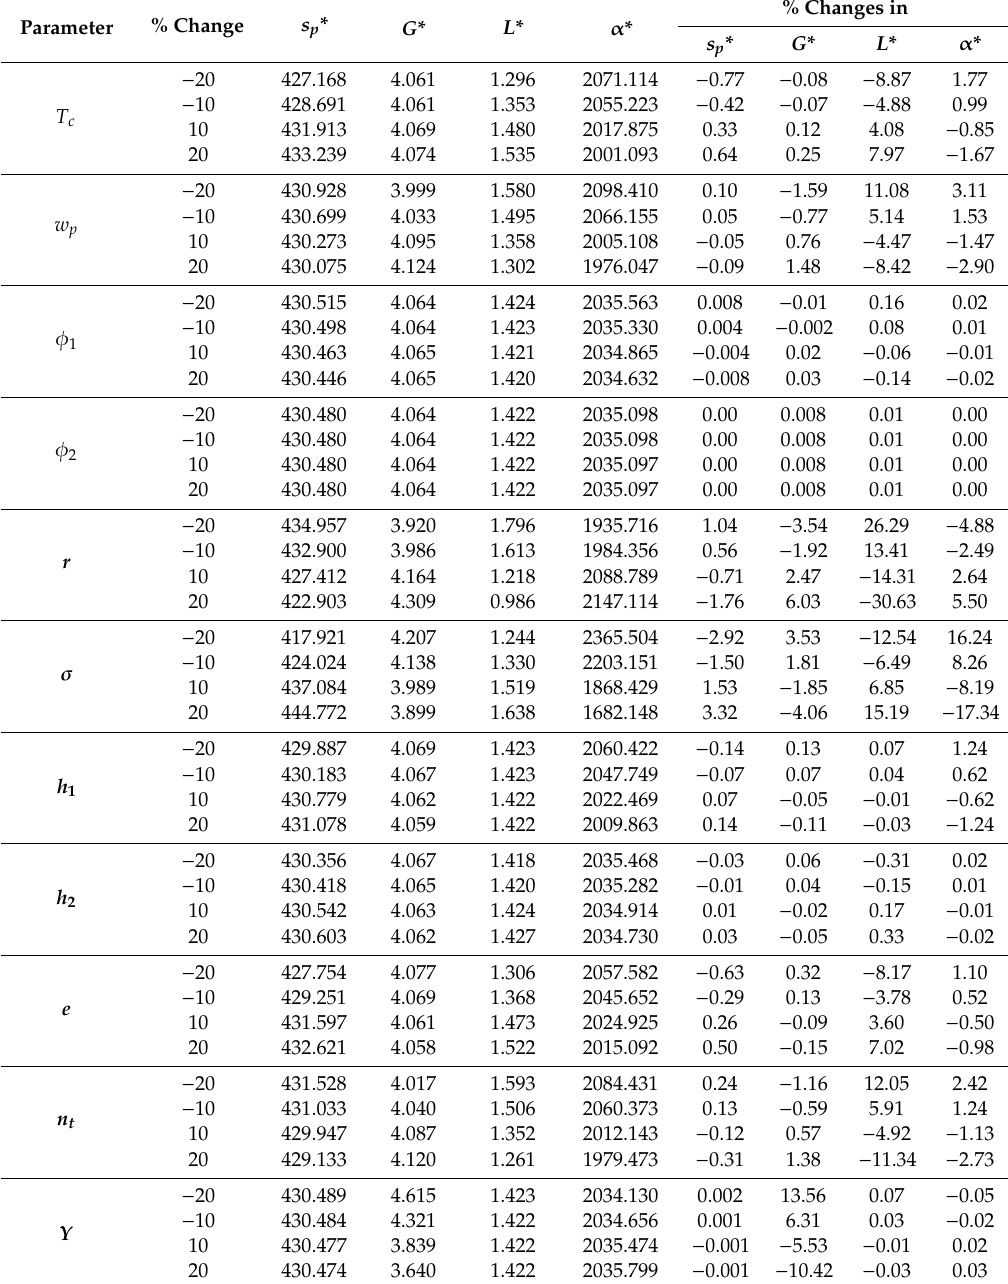
Table 2. Sensitivity analysis with respect to di ff erent